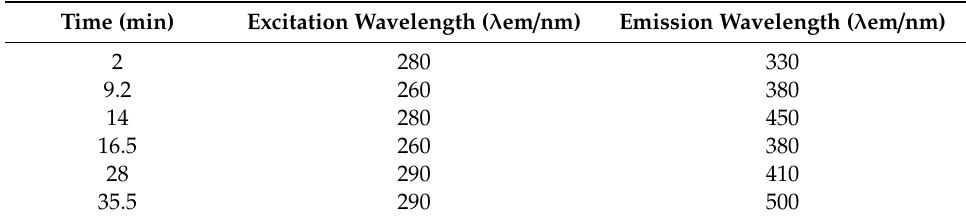
Table A2. The excitation and emission wavelengths of florescence detector (FLD) for quantitative analysis of PAHs.